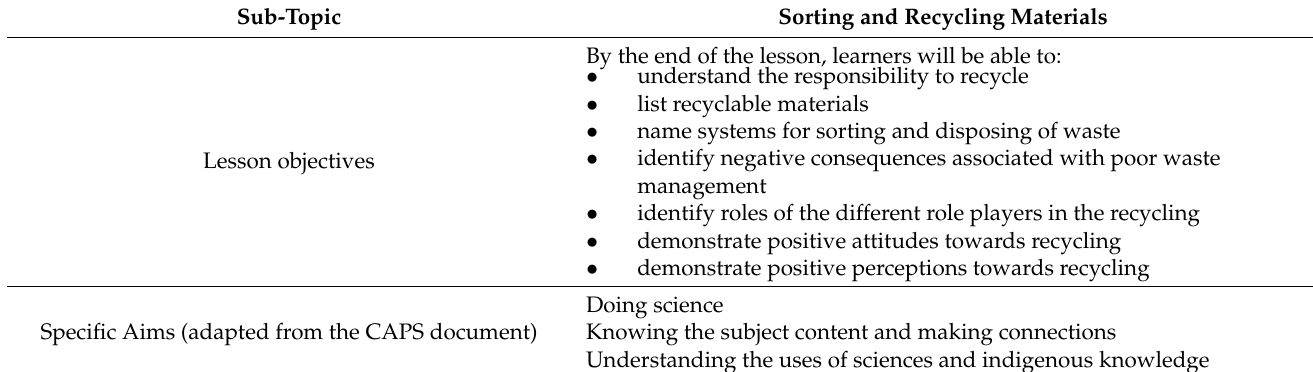
Table 1. The school-based recycling project worksheet used by learners. The worksheet included the learning objective, specific aims of the project, science process skills to be developed, and instructions for learners.